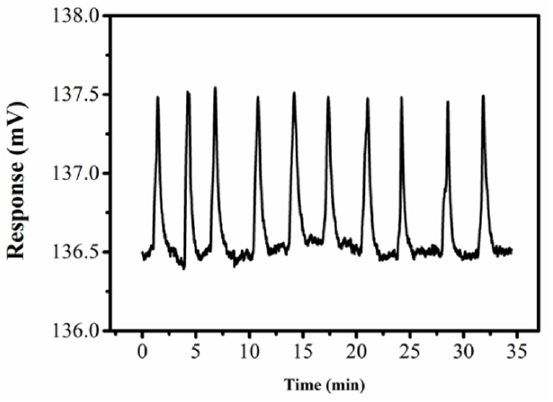
Figure 10. Response curve of DISODCD for 10 repeats to 10 nM KCl solution.